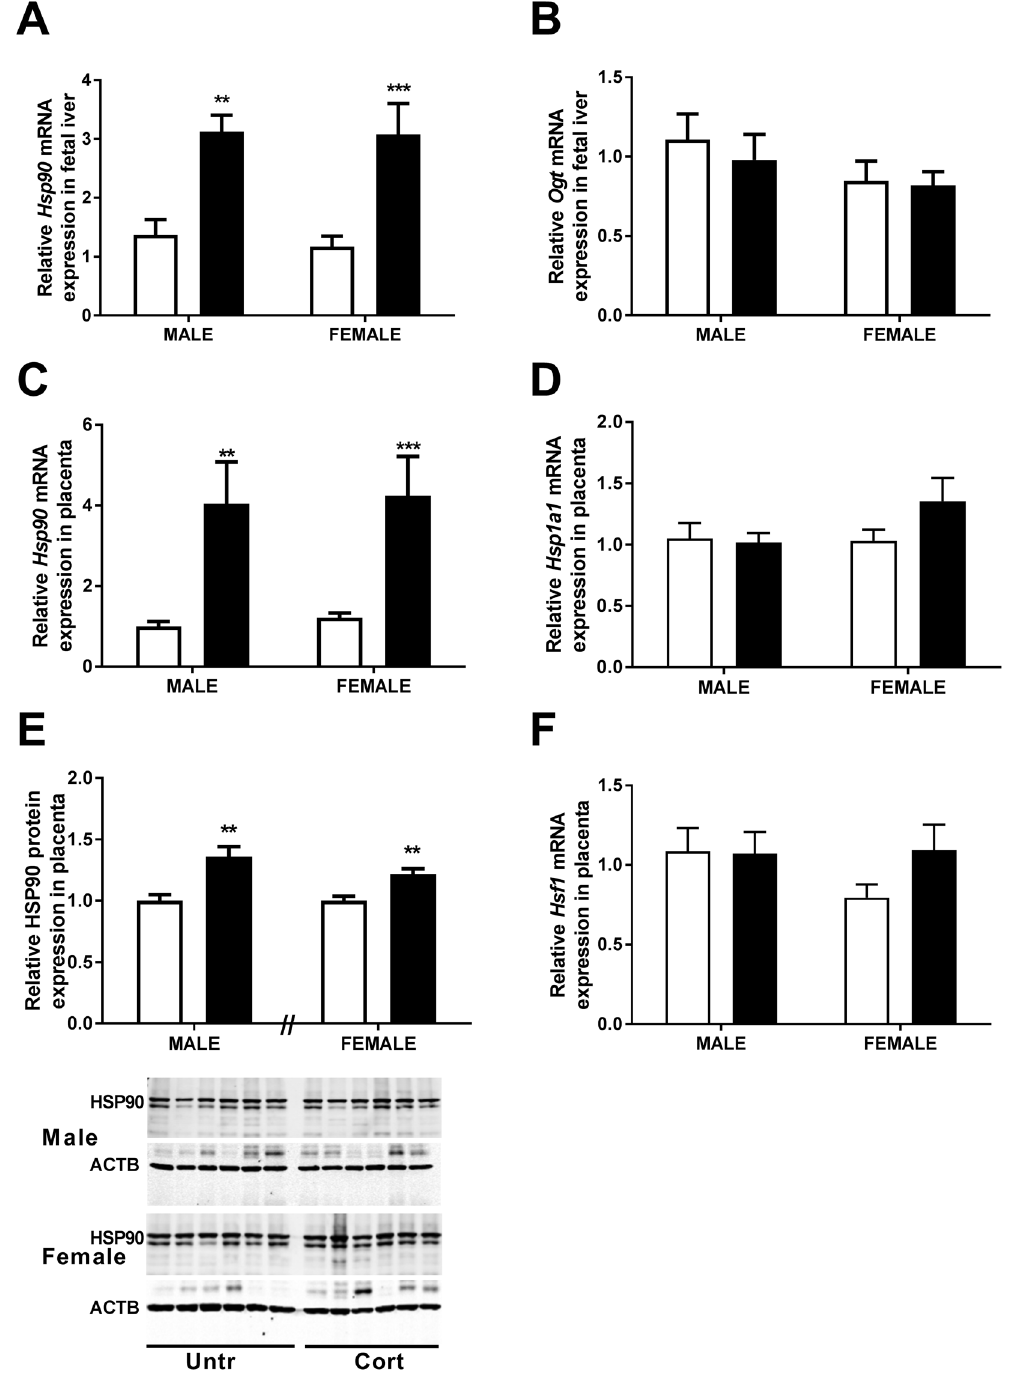
Figure 2. The effects of corticosterone exposure (black bars) on ( A ) relative mRNA expression of Heat Shock Protein 90 ( Hsp90 ) and ( B ) O-linked β -N-Acetylglucosamine ( Ogt ) in liver tissue along with ( C ) Hsp90 , ( D ) Heat shock protein 70 ( Hsp1a1 ) and ( F ) Heat Shock Factor 1 ( Hsf1 ) in placental tissue of male and female C57/ BL6 fetuses at E14.5 compared with untreated controls (white bars). Relative HSP90 protein concentrations were also assessed ( E ) in both male and female placentae at E14.5 (n = 6 per treatment). Data represented as mean + SEM. ** P < 0.01, *** P < 0.001 for post hoc analysis or t- test results. Real-time quantitative PCR used to determine gene expression, and normalised to β -Actin and 18S RNA levels. RNA data were analysed using a two-way ANOVA comparing the factors treatment and sex with Bonferroni’s post hoc testing presented on graph (n = 9–11). Protein expression was examined by western immunoblot with β -Actin (ACTB) as loading control, normalised to the mean of the untreated control of the same sex (Top band analysed for HSP90). Protein expression was analysed using a two-tailed t- test with untreated controls of the same sex (n =